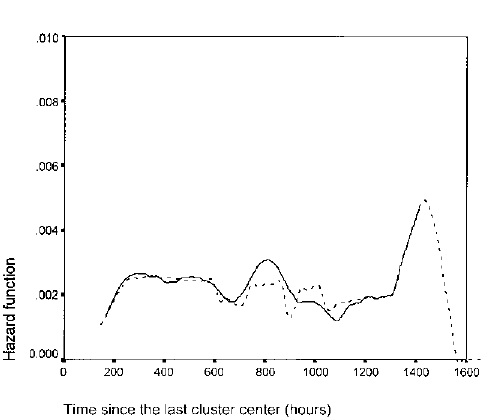
Fig. 18. Hazard estimation of time intervals between center clusters with global bandwidth (solid line) and local bandwidths (dashed line).